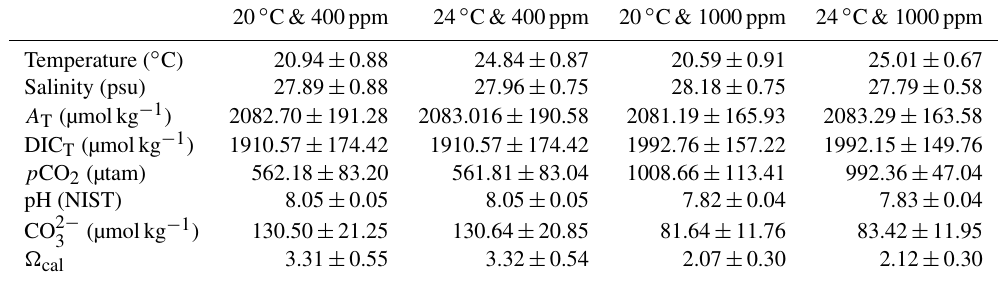
Table 1. Measured and calculated seawater carbonate chemistry variables of each acclimation treatment during the experimental period ∗